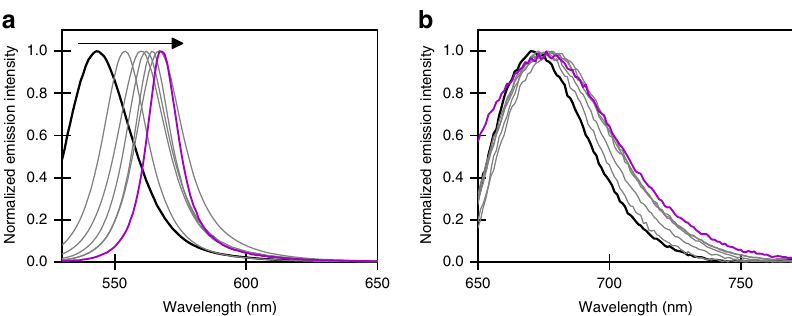
Fig. 3 Selective coupling of excited states and decrease of triplet – singlet energy gap. a Fluorescence/ P − emission and b phosphorescence spectra of ErB/ PVA fi lms inside a cavity with an ErB concentration between 0.01 (black) and 0.54 M (purple), excited at the maximum of the P + absorbance. The clean phosphorescence band was obtained by subtracting the fl uorescence tail from the phosphorescence spectra (Supplementary Fig. 3)